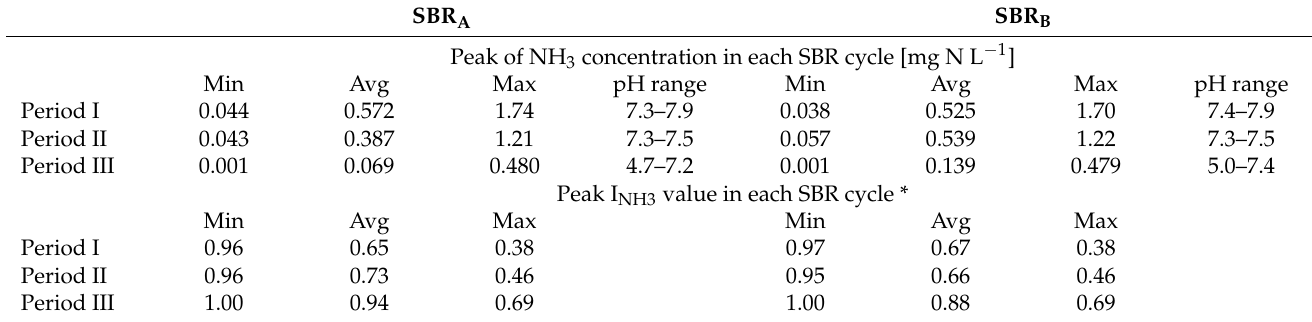
Table 6. Peak of NH 3 concentration in each SBR cycle and I NH3 values in SBR A and in SBR B . SBR A SBR